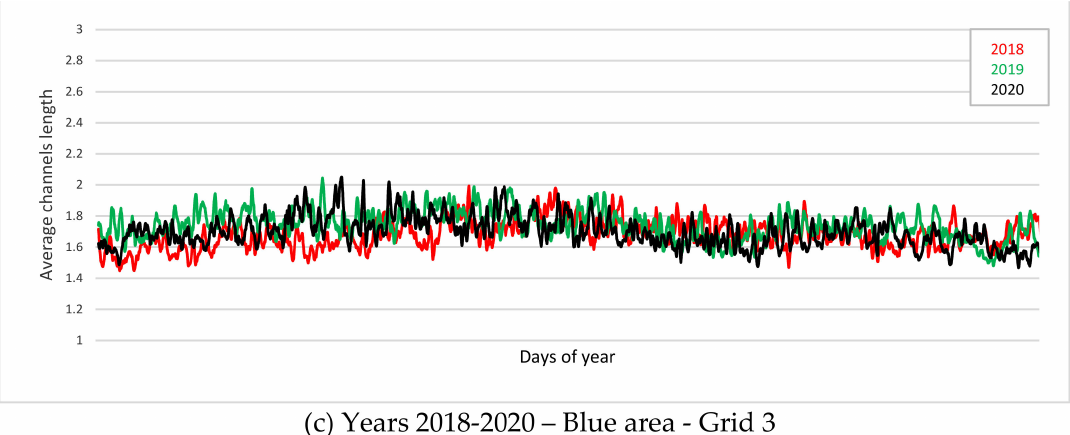
Figure 9. Results corresponding to the average length of channels constituted from 2018 to 2020 in the blue geographical area under study.